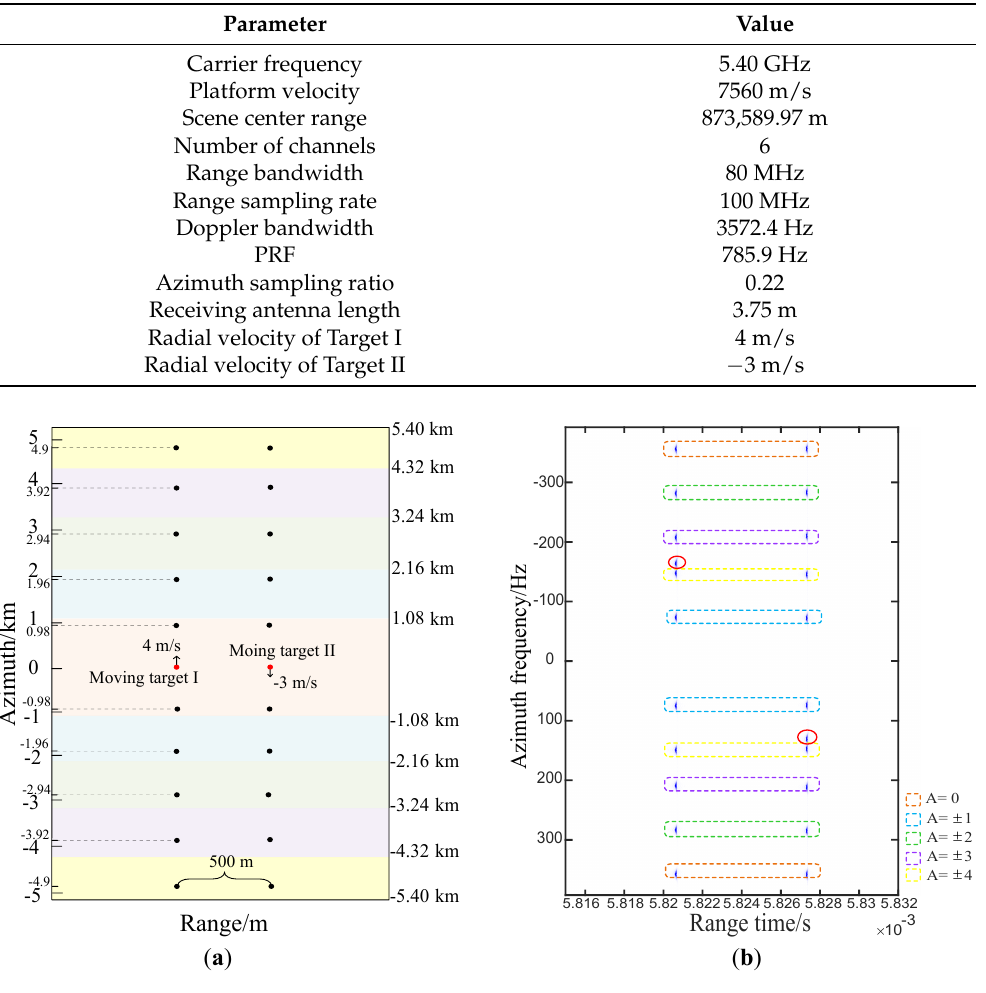
Figure 8. Target distribution and preliminary experiment results, ( a ) the distribution of simulated targets with different aliasing coefficients, ( b ) signals after the deramp processing in azimuth- frequency